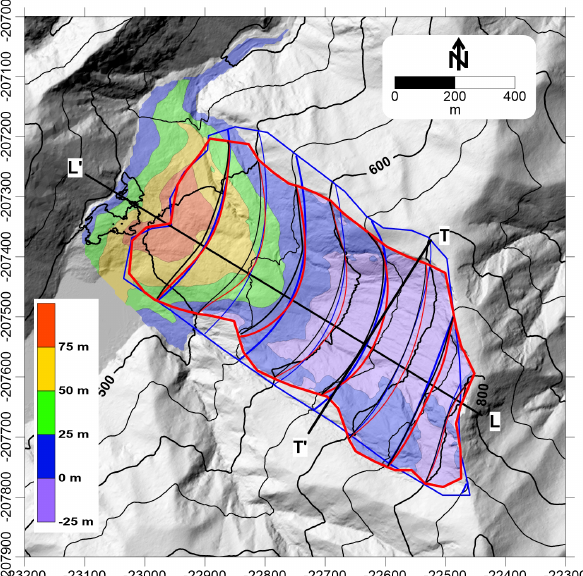
Figure 23. Hillshade from the 1m post-DEM of the Nagatono land- slide with contour lines displaying the various results. In red, mixed scenario 2 (the preferred solution); in black, mixed scenario 1; and in blue, scenario 1. The coloured area refers to the thickness de- duced from the subtraction of the post-DEM from mixed scenario 2.